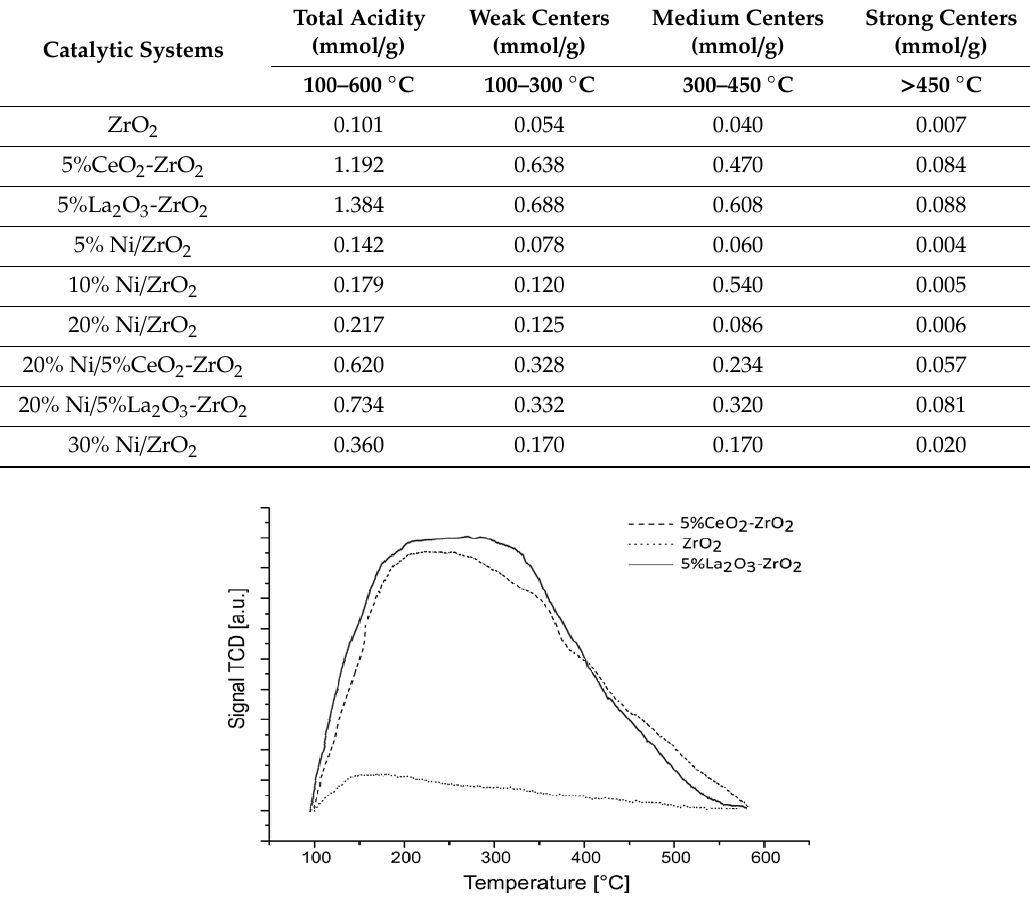
Table 5. Amount of NH 3 adsorbed on the surface of ZrO 2 and the reduced monometallic Ni-supported catalysts (reduction for 1 h in pure hydrogen at 500 ◦ C) calculated from the surface under the peaks recorded during temperature-programmed desorption measurements.